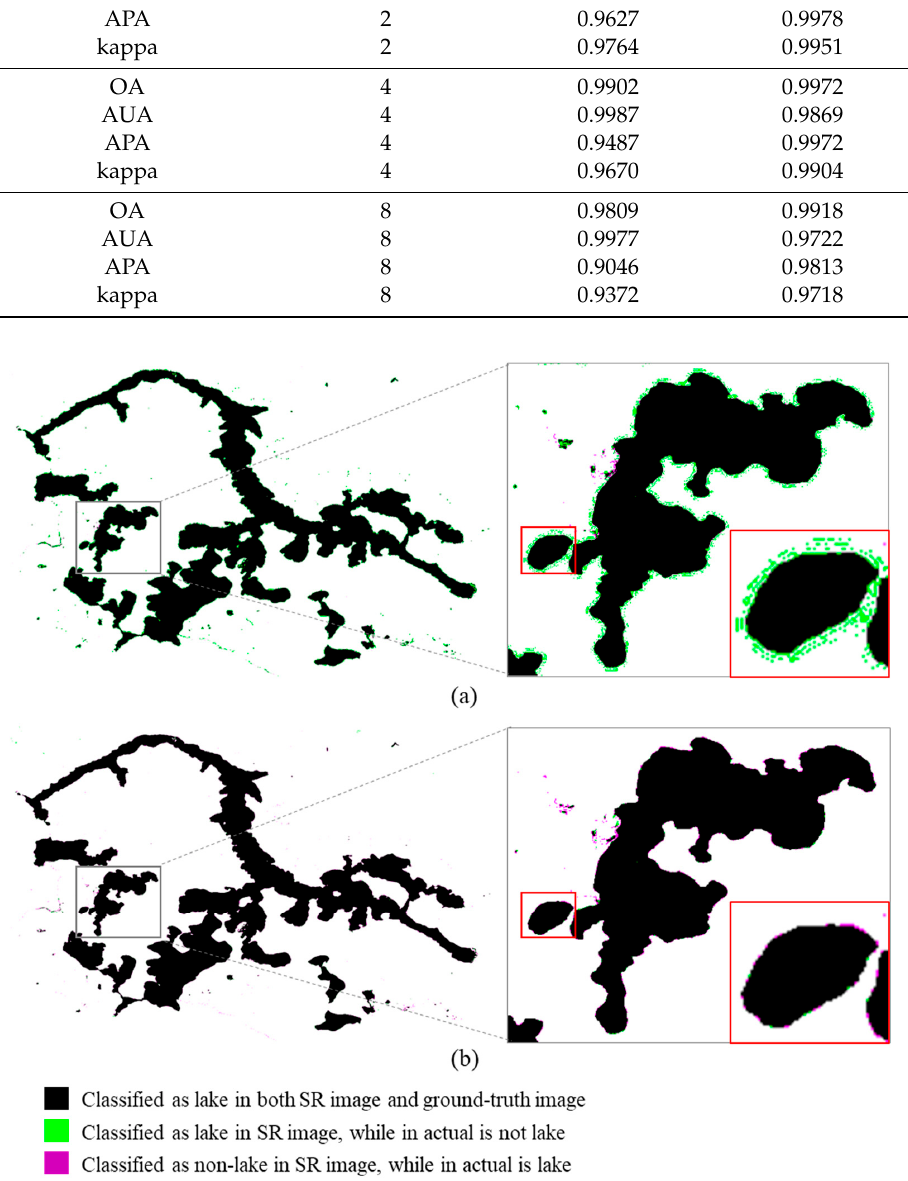
Figure 7. Di ff erence between SR images and ground-truth image. ( a ) Di ff erence between strategy 1 Figure 7. Difference between SR images and ground-truth image. ( a ) Difference between strategy 1 and the ground-truth image, ( b ) Di ff erence between strategy 2 and the ground-truth and the ground-truth image, ( b ) Difference between strategy 2 and the ground-truth image.